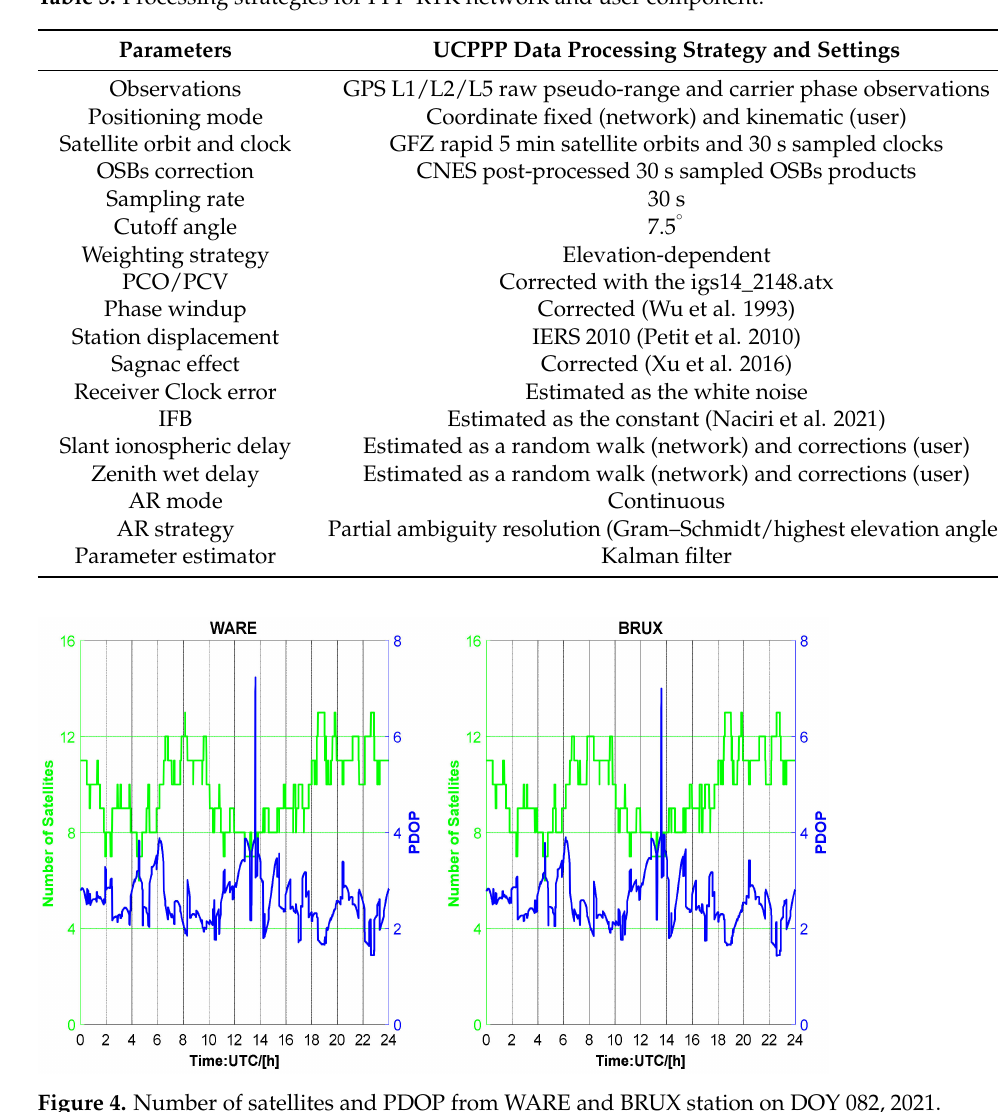
Table 3. Processing strategies for PPP-RTK network and user component.